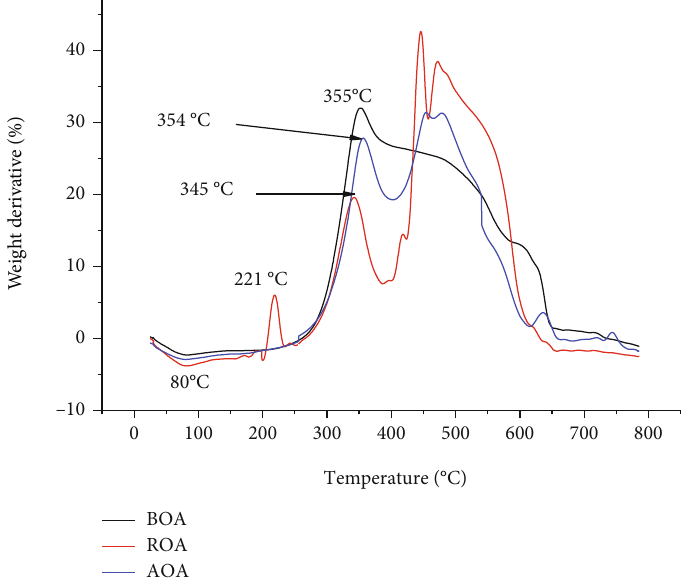
Figure 10: DTA curve of ROA, AOA, and BOA fi bers.